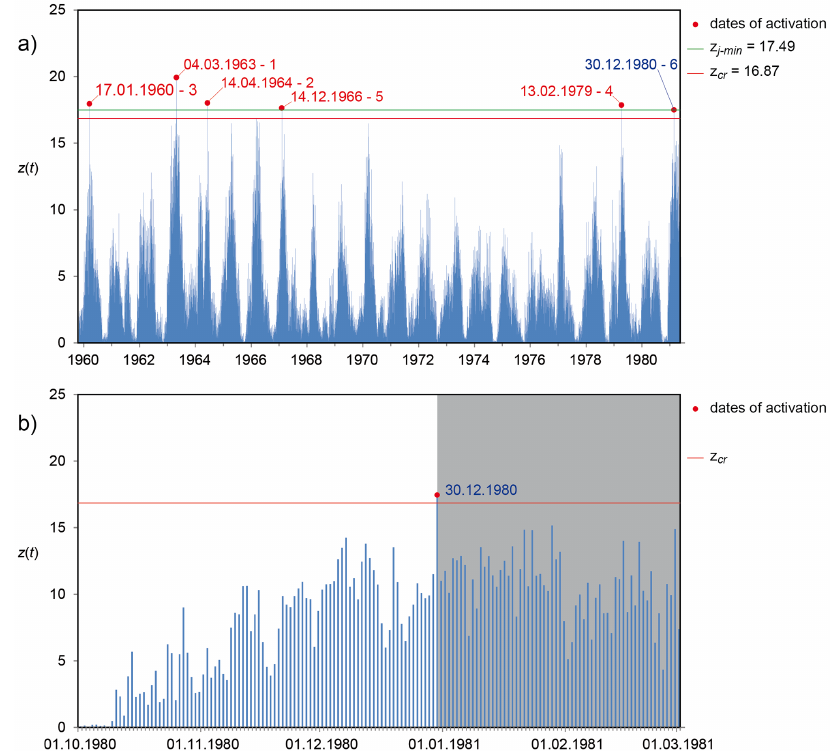
Figure 17. Uncino landslide case study. (a) Validation of the average kernel against the no. 6 event. (b) Particular of (a) , limited to the period ± t b including the date of validation. Key as in Fig. 15. The blue label indicates the date of validation. Grey background marks the period after the event that may be employed for re-calibration.